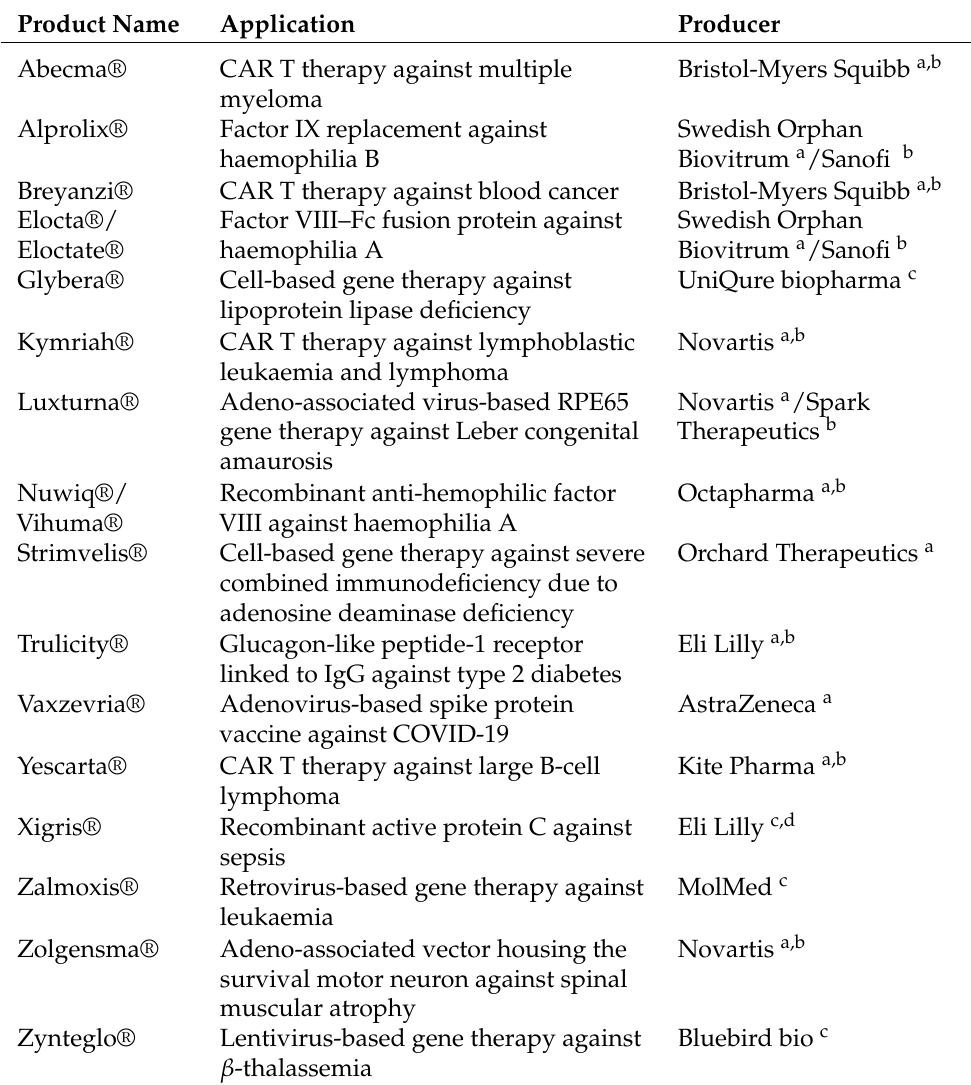
FDA- and EMA-approved biologics produced with HEK293 cells, extended from Tan et al. [3], Pulix et al. [35], Dumont et al. [36], and Walsh and Walsh